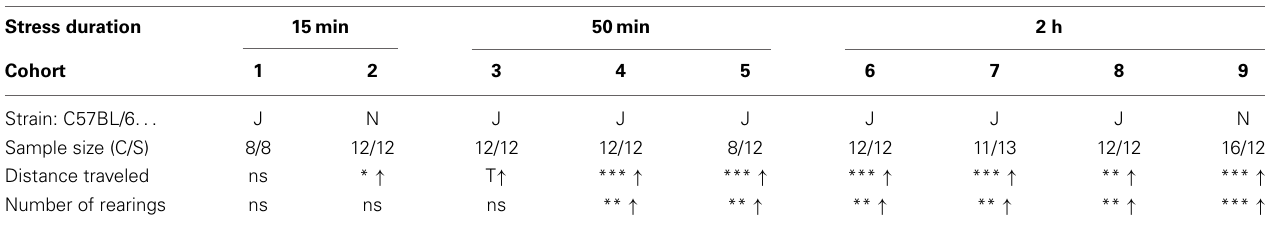
Table 1 | First 5min of the OF with different stress durations and cohorts. Stress duration 15min Cohort Strain: